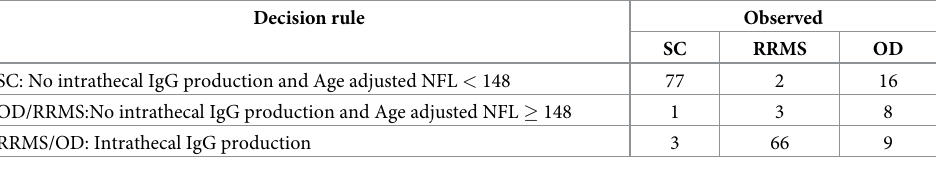
Table 2. Predicted and observed group membership using a classification tree model with intrathecal IgG produc- tion and NFL. The formula for age adjusted NFL is given by NFL– 203.3–15.9 (cid:3) Age (y), as estimated by linear regres- sion in healthy controls.